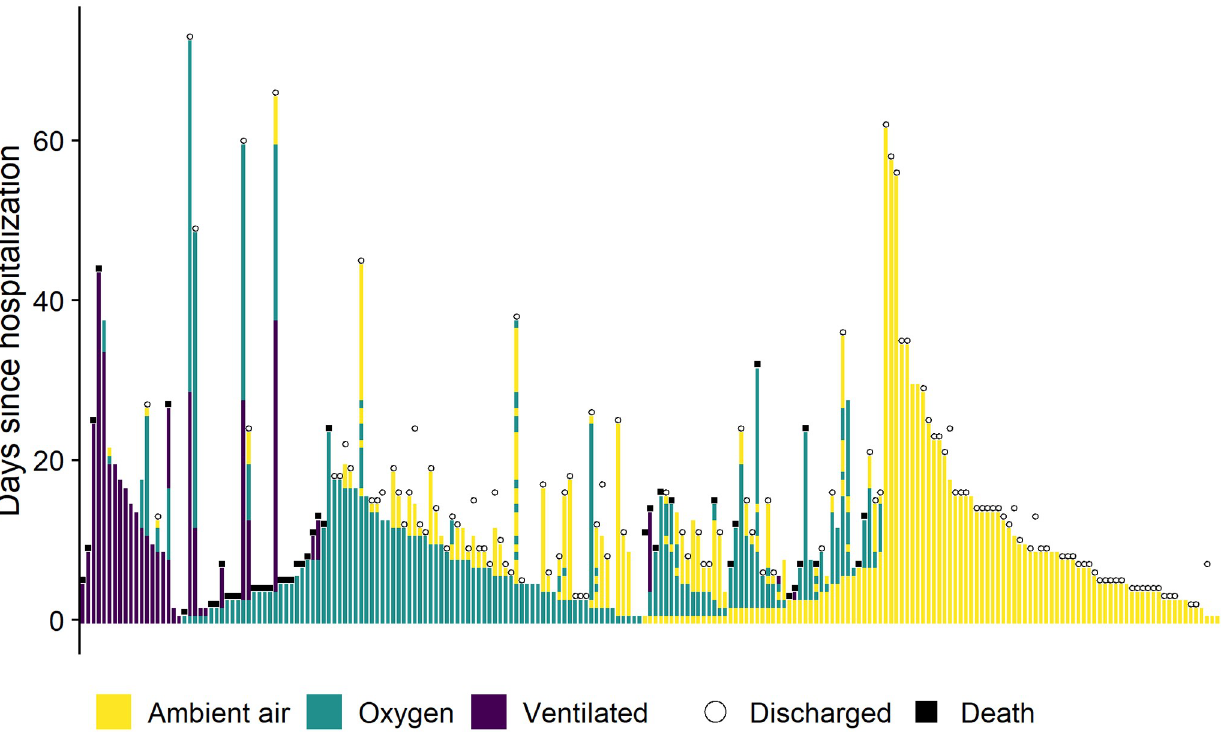
Fig 2. Disease progression for all patients included in the study as determined by breathing support required. Each vertical strip is a single patient, the ordering on the horizontal axis is by disease severity. Ventilated = any form of ventilation (non-invasive positive-pressure ventilation, mechanical ventilation and extra-corporeal membrane